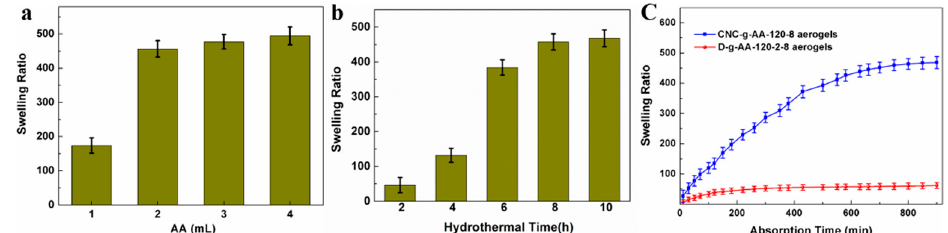
Figure 4. ( a ) Swelling ratio of CNC-g-AA-r-120-8 aerogels with different AA contents; ( b ) Swelling ratio of CNC-g-AA-2-120-n aerogels hydrothermally treated for different times; ( c ) Adsorption capacity of D-g-AA-2-120-8 aerogels and CNC-g-AA-2-120-8 aerogels compared with the adsorption time.